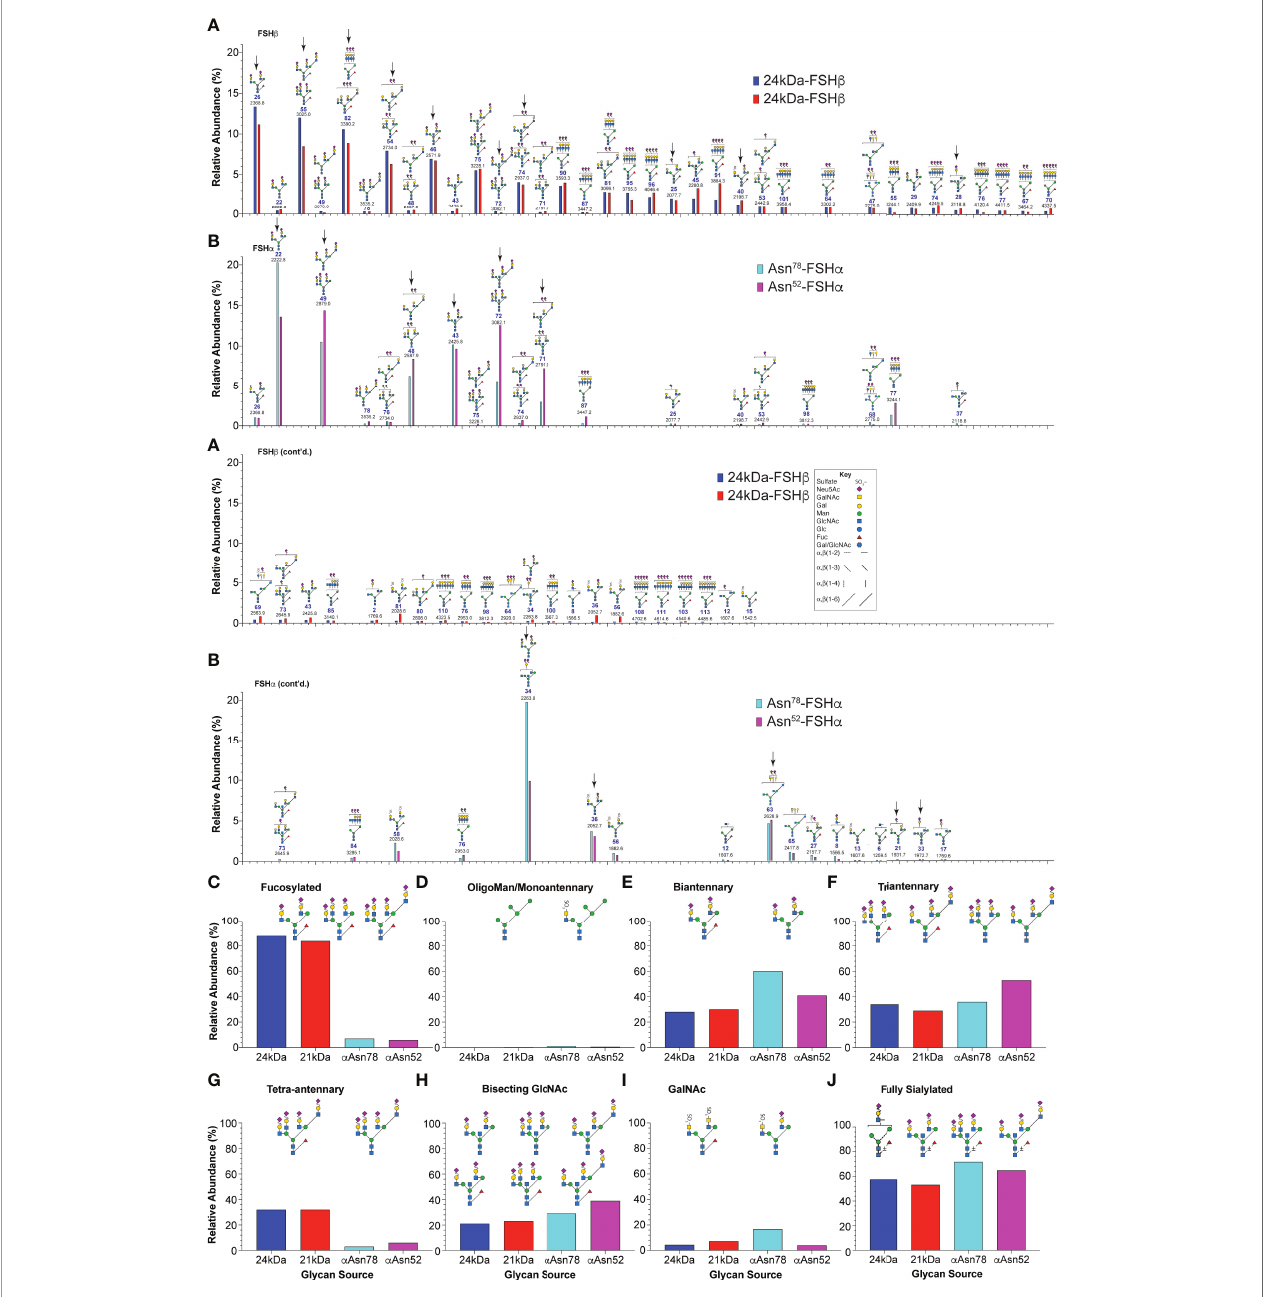
FIGURE 3 | Human pituitary FSH glycan populations. (A) Glycans derived from 24kDa- (blue) and 21kDa-FSH b (red) roughly in order of core fucosylated 24kDa- FSH b glycan abundance, interrupted by otherwise identical structures lacking core fucose. (B) Glycans derived from a Asn 78 (cyan) and a Asn 52 (magenta) shown in the same order as in panel (A) Glycan abundances are presented as % of total glycans observed using the values in Table 1 . Glycan structures are displayed using the hybrid Oxford Glycobiology Institute/Consortium for Functional Glycoscience system (1, 62). The former identi fi es linkages without the use of labels, while the latter uses a proposed symbol and color scheme for individual monosaccharide residues (shown in the Key). Arrows identify those glycans observed in site-speci fi c glycopeptide studies (10, 11) (C) Relative abundance of glycans possessing core fucose residues. (D) Relative abundance of oligomannose or hybrid type glycans. (E) Relative abundance of biantennary glycans, as de fi ned by the presence of the branch-initiating GlcNAc. (F) Relative abundance of tri-antennary glycans. (G) Relative abundance of tetra-antennary glycans. (H) Relative abundance of glycans possessing a bisecting GlcNAc residue. (I) Relative abundance of glycans possessing a GalNAc residue. (J) Glycans possessing enough Neu5Ac to terminate all